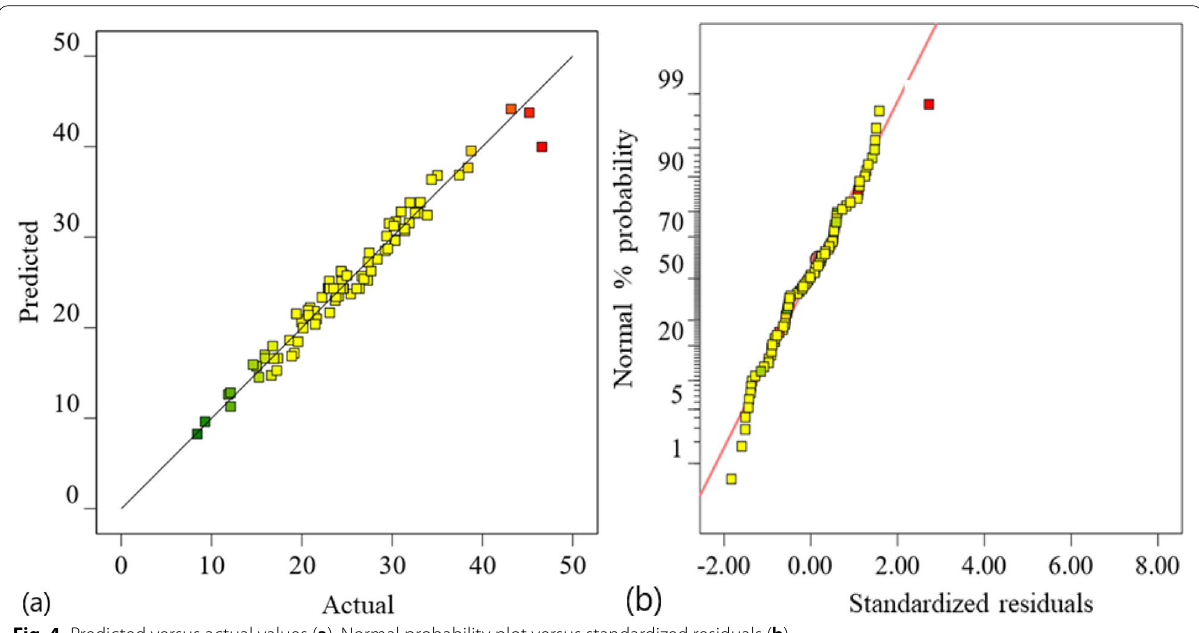
Fig. 4 Predicted versus actual values ( a ). Normal probability plot versus standardized residuals ( b )